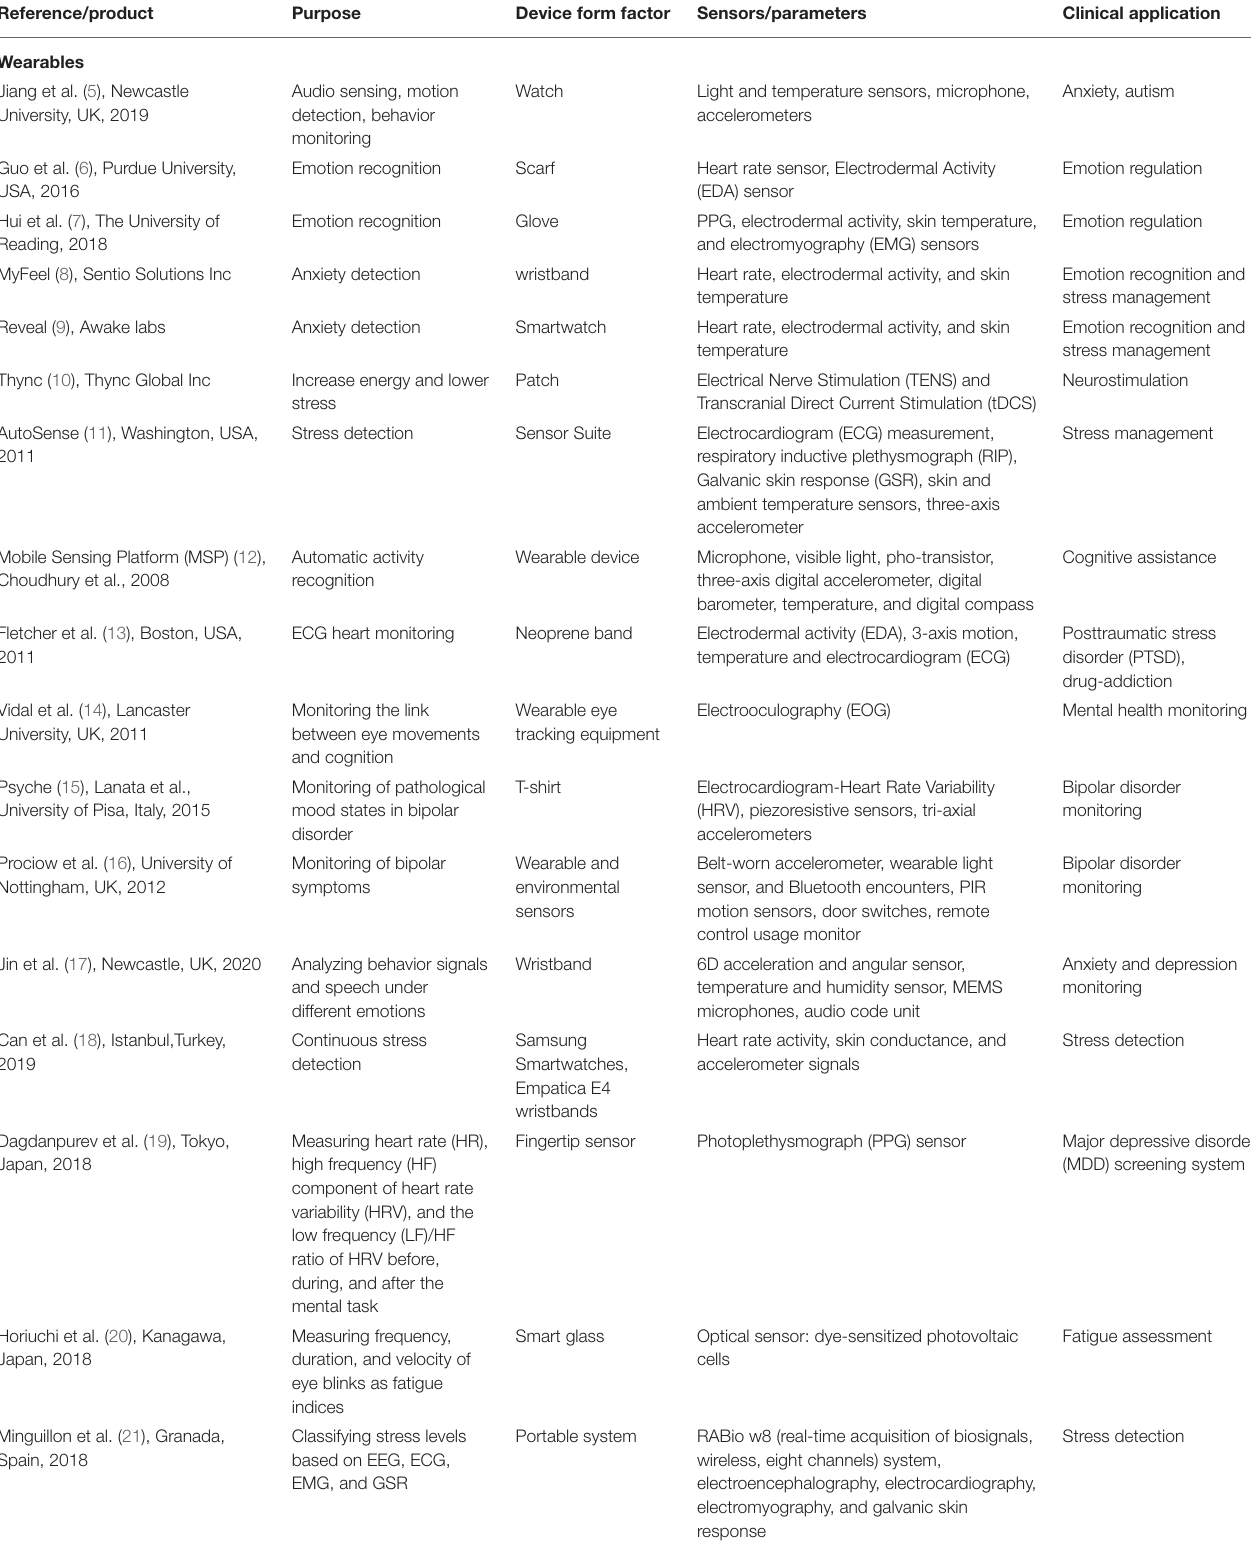
TABLE 1 | Wearable physiological and emotional monitoring research